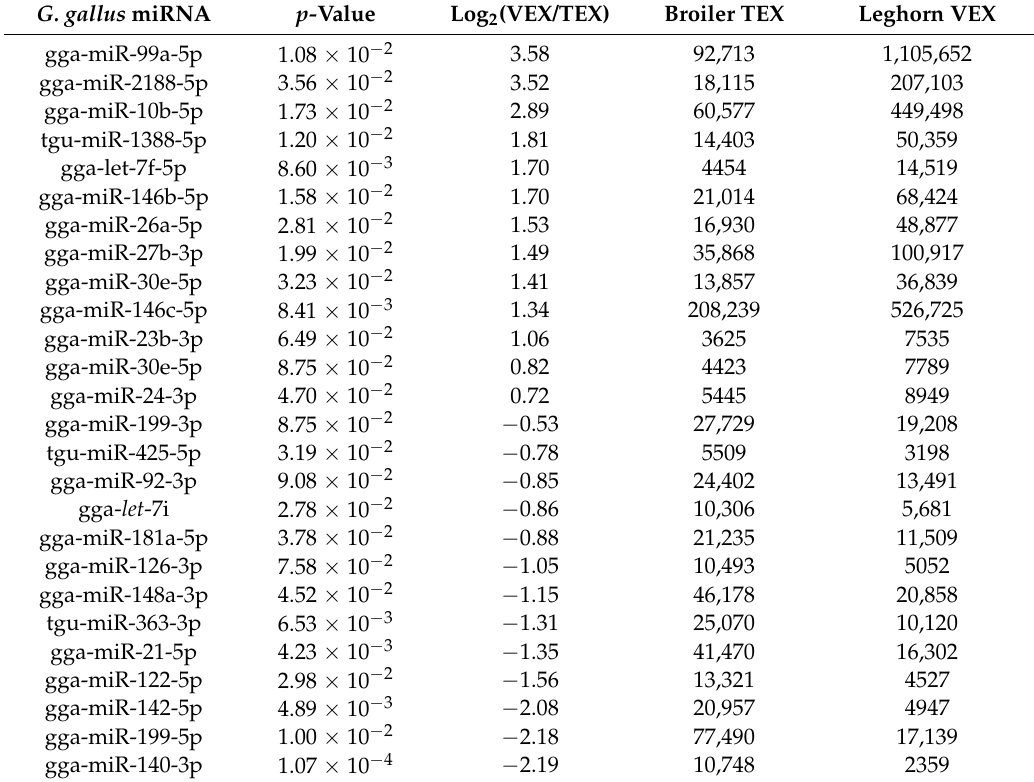
Table 3. Gallus miRNA read counts and miRNA expression in VEX and broiler